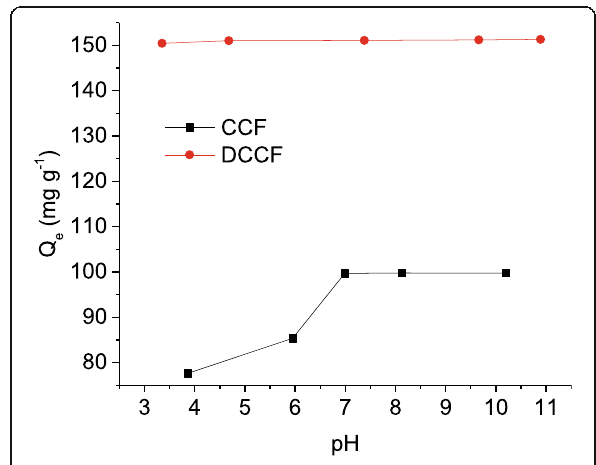
Fig. 10 Effect of initial solution pH on adsorption capacity of CCF and DCCF using an initial 50 mL of 30 ppm MB